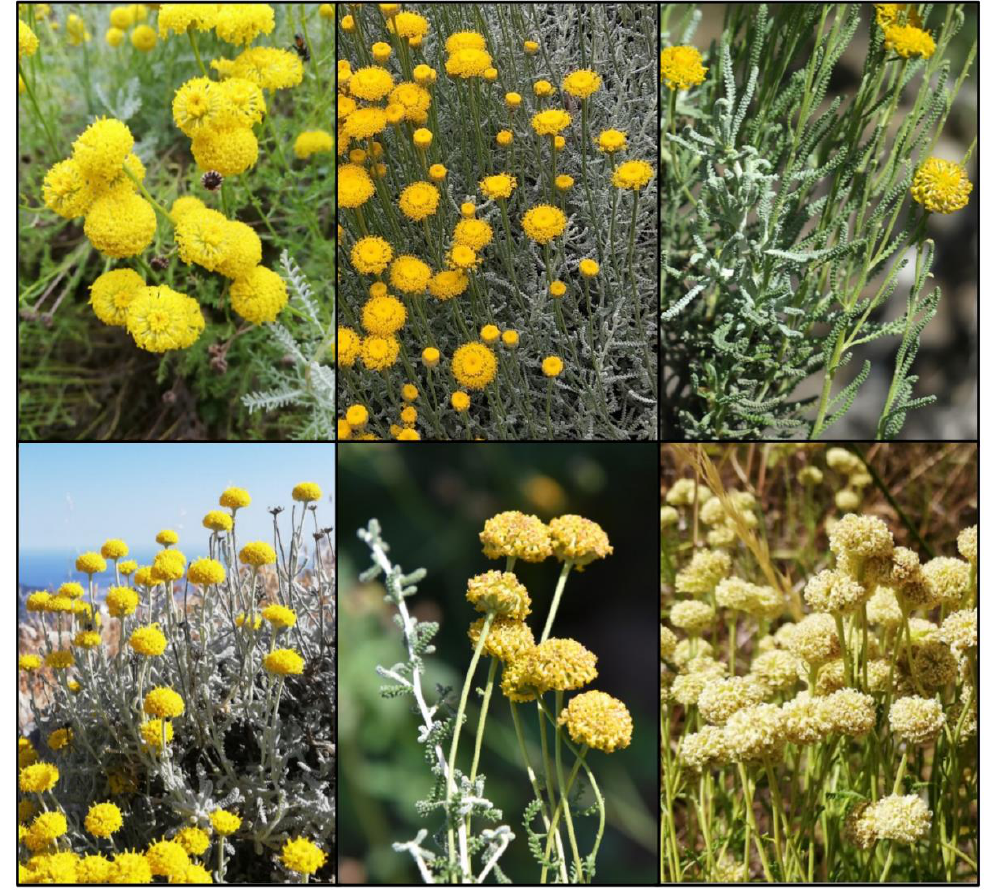
Figure 3. Cont Figure 3. The pictures of the species of the S. chamaecyparissus complex. From left to right: Santolina benthamiana (France, Occitanie, Prats-de-Mollo, photo by L. Peruzzi), S. chamaecyparissus (Italy, Tuscany, Orto e Museo Botanico di Pisa, photo by P. De Giorgi), S. corsica (Italy, Sardinia, Buggerru, photo by S. Cambria), S. decumbens s.str. (France, Provence-Alpes- Côte d’Azur, Mont Caume, photo by L. Peruzzi), S. ericoides (Spain, Barcelona, Sant Feliu de Codines, photo by L. Sáez), and S. etrusca (Italy, Tuscany, Arcidosso, photo by L. Peruzzi).